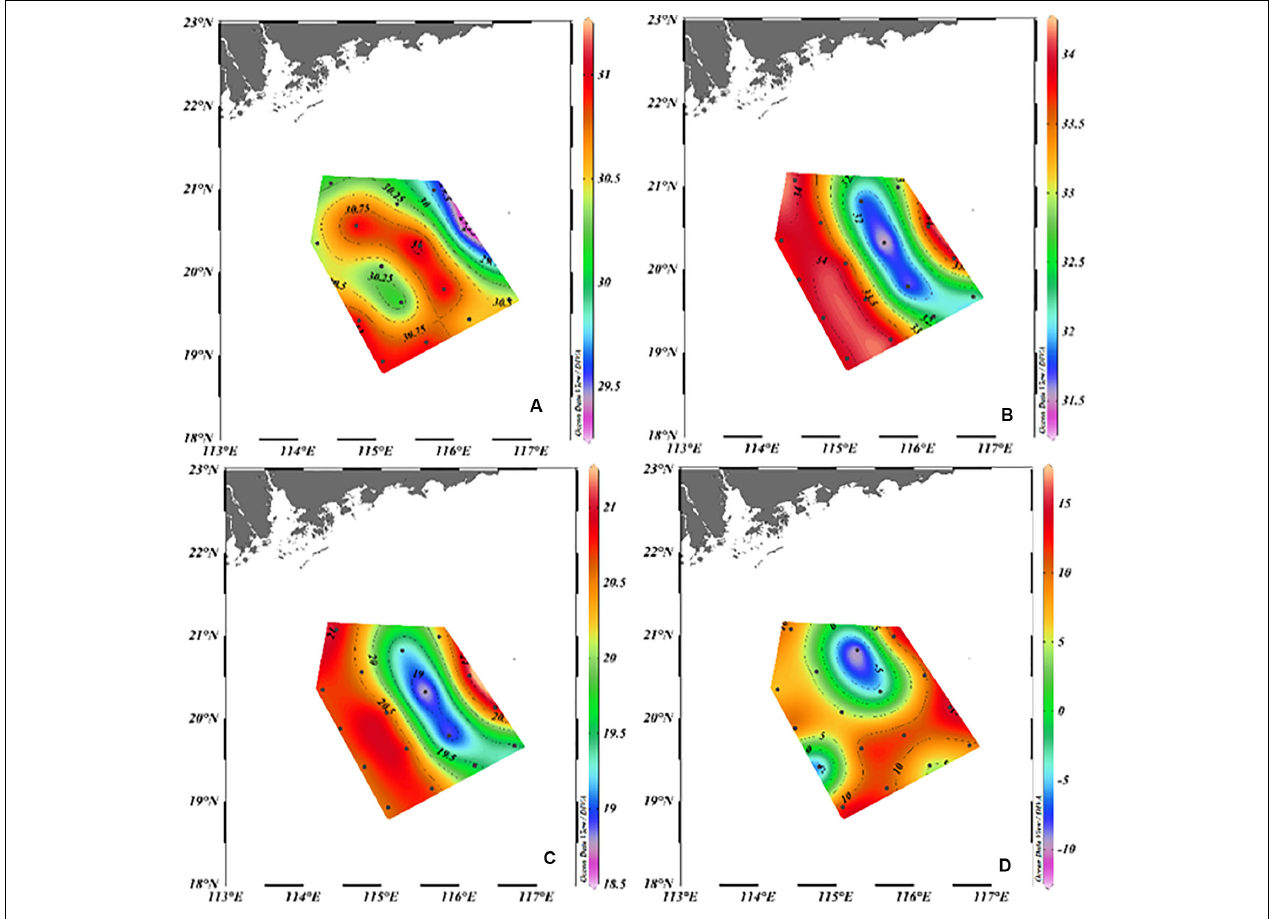
FIGURE 2 | The surface distribution of temperature ( ◦ C) (A) , salinity (B) , σ t (C) , and AOU ( µ mol L − 1 ) (D) in June